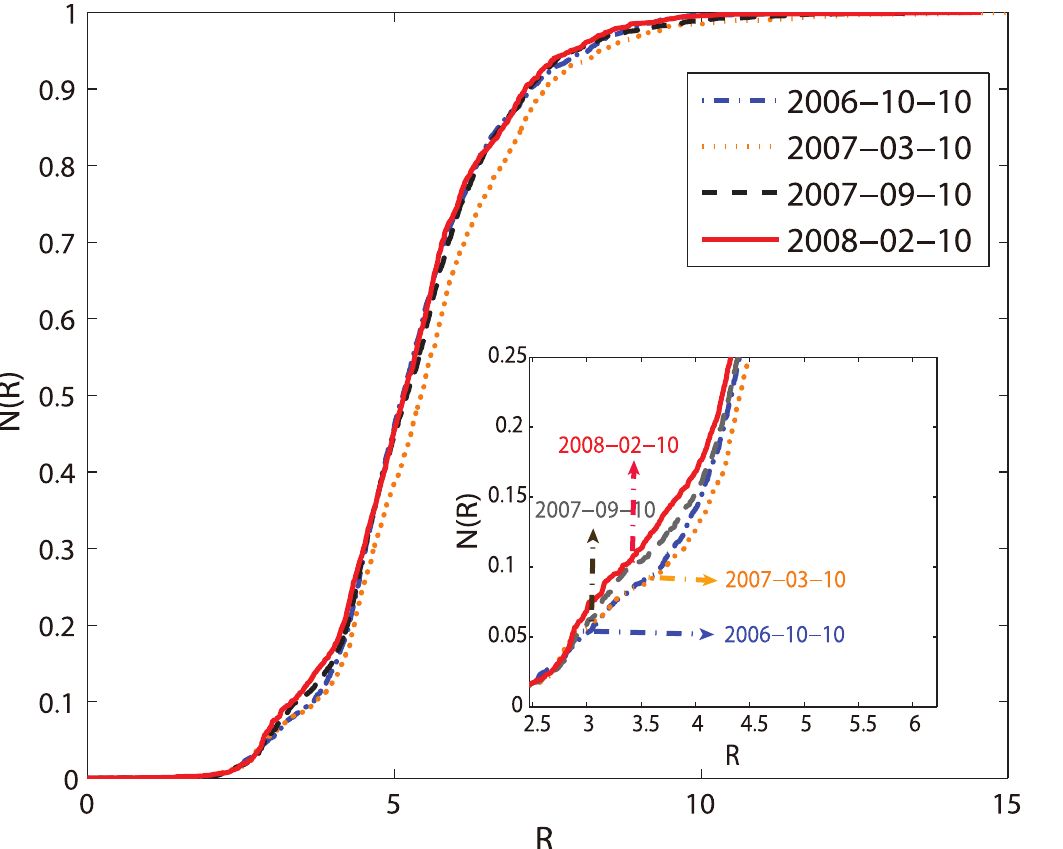
Fig 8. The “ S ” curves of the number of websites in different time by distinct